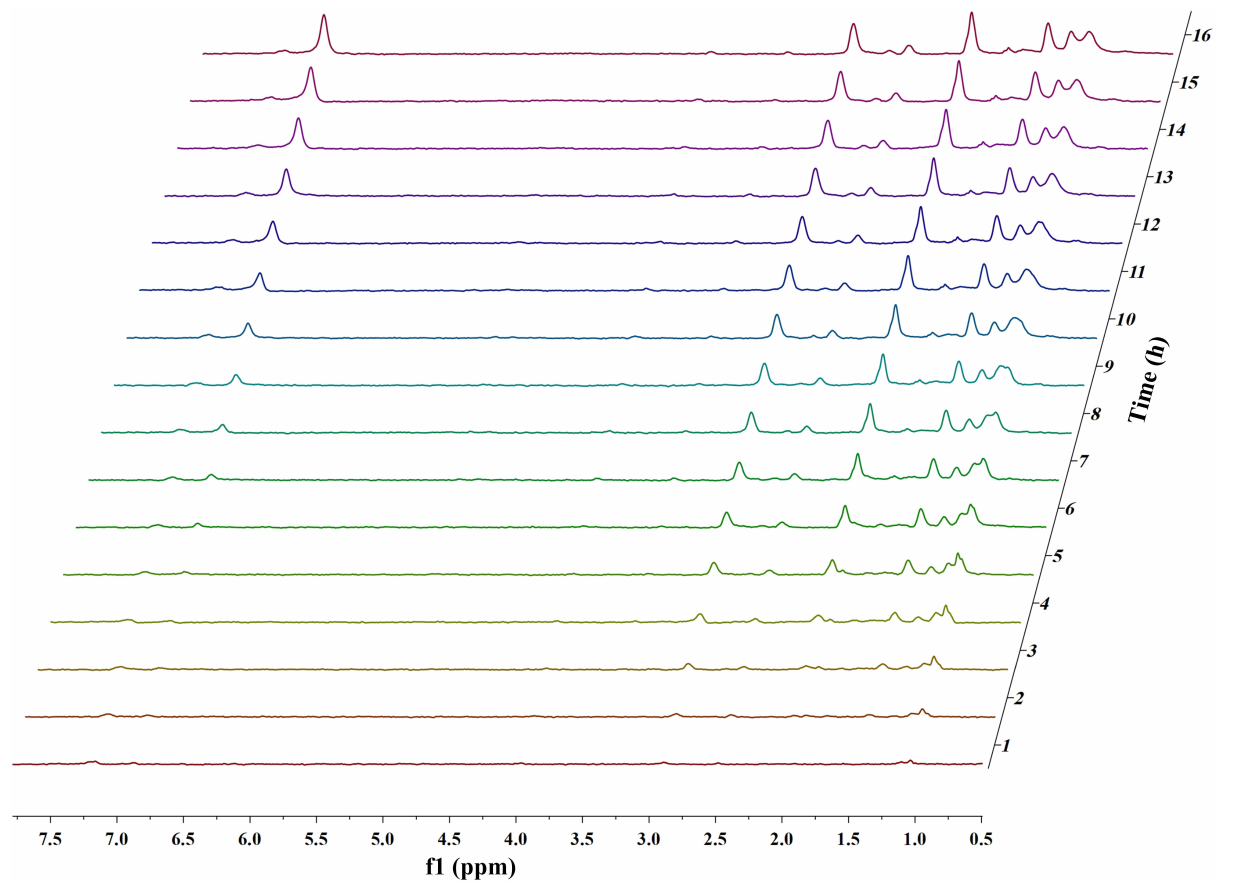
exchanged with deuterium was the hydrogen 13(14) (the number of atoms can be found in to the Figure 3 ) and the hydrogen of